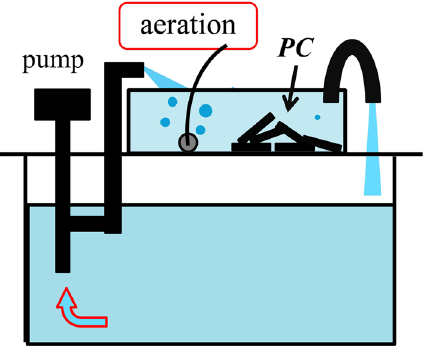
Fig. 1 Experimental set-up for the purification of artificial water (15 L) containing 10 mL of milk, 15 mL of activated sludge (AS), and 750 g of porous ceramics